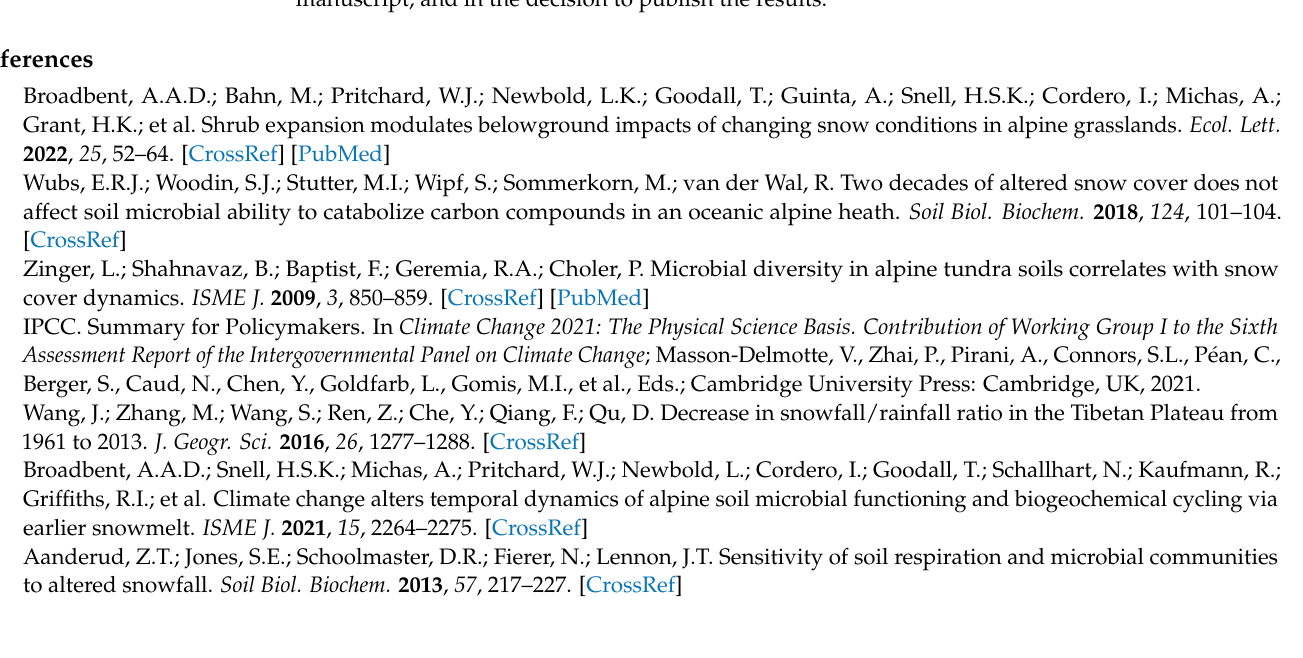
Table S1: Sequencing results and number of observed and estimated OTUs at the species level (70% amoA